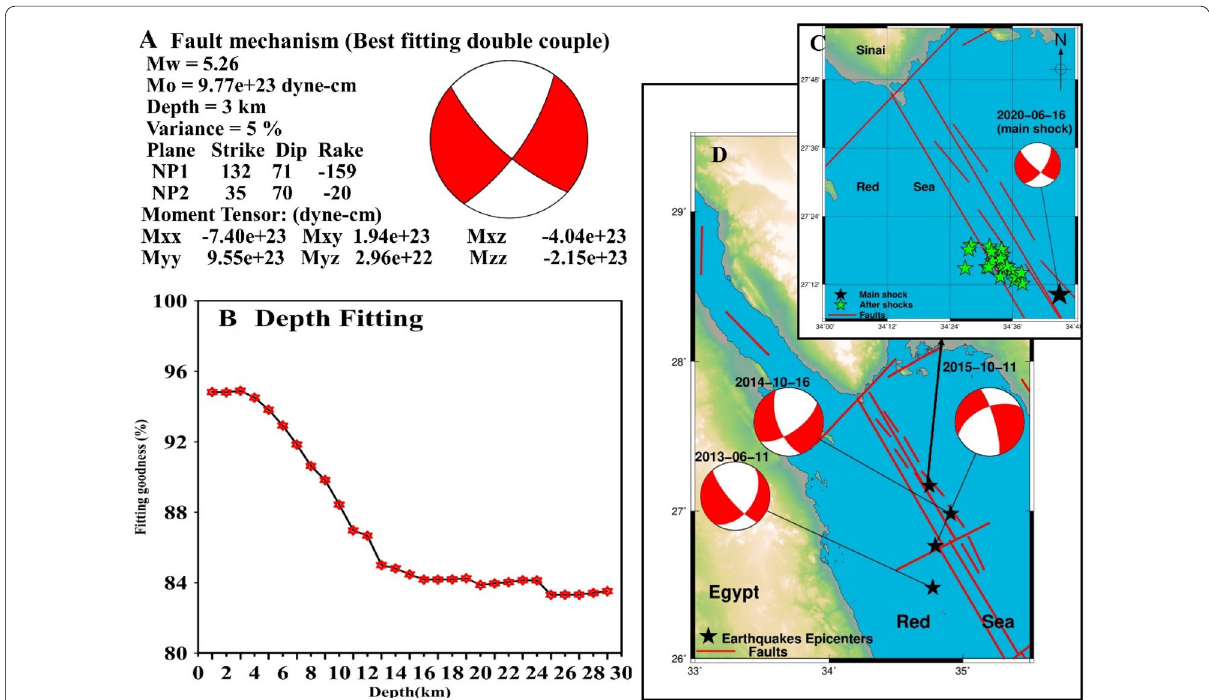
Fig. 5 A The best-fitting fault mechanism of the 16 Jun, 2020 earthquake. B The correspondence best depth fitting, and C the aftershock clustered and distribution with the best double-couple solution of the mainshock; D the focal mechanism distribution obtained by previous